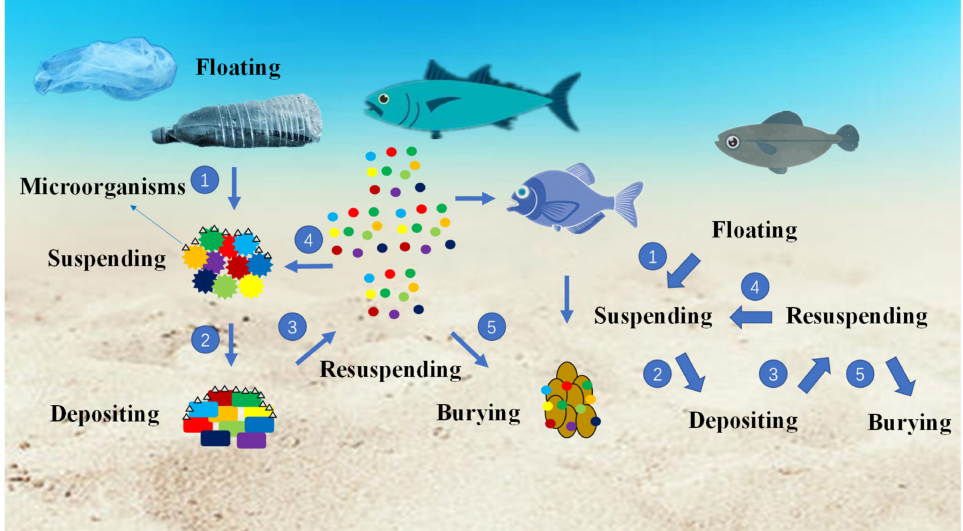
Figure 4. The transformation of microplastics in water